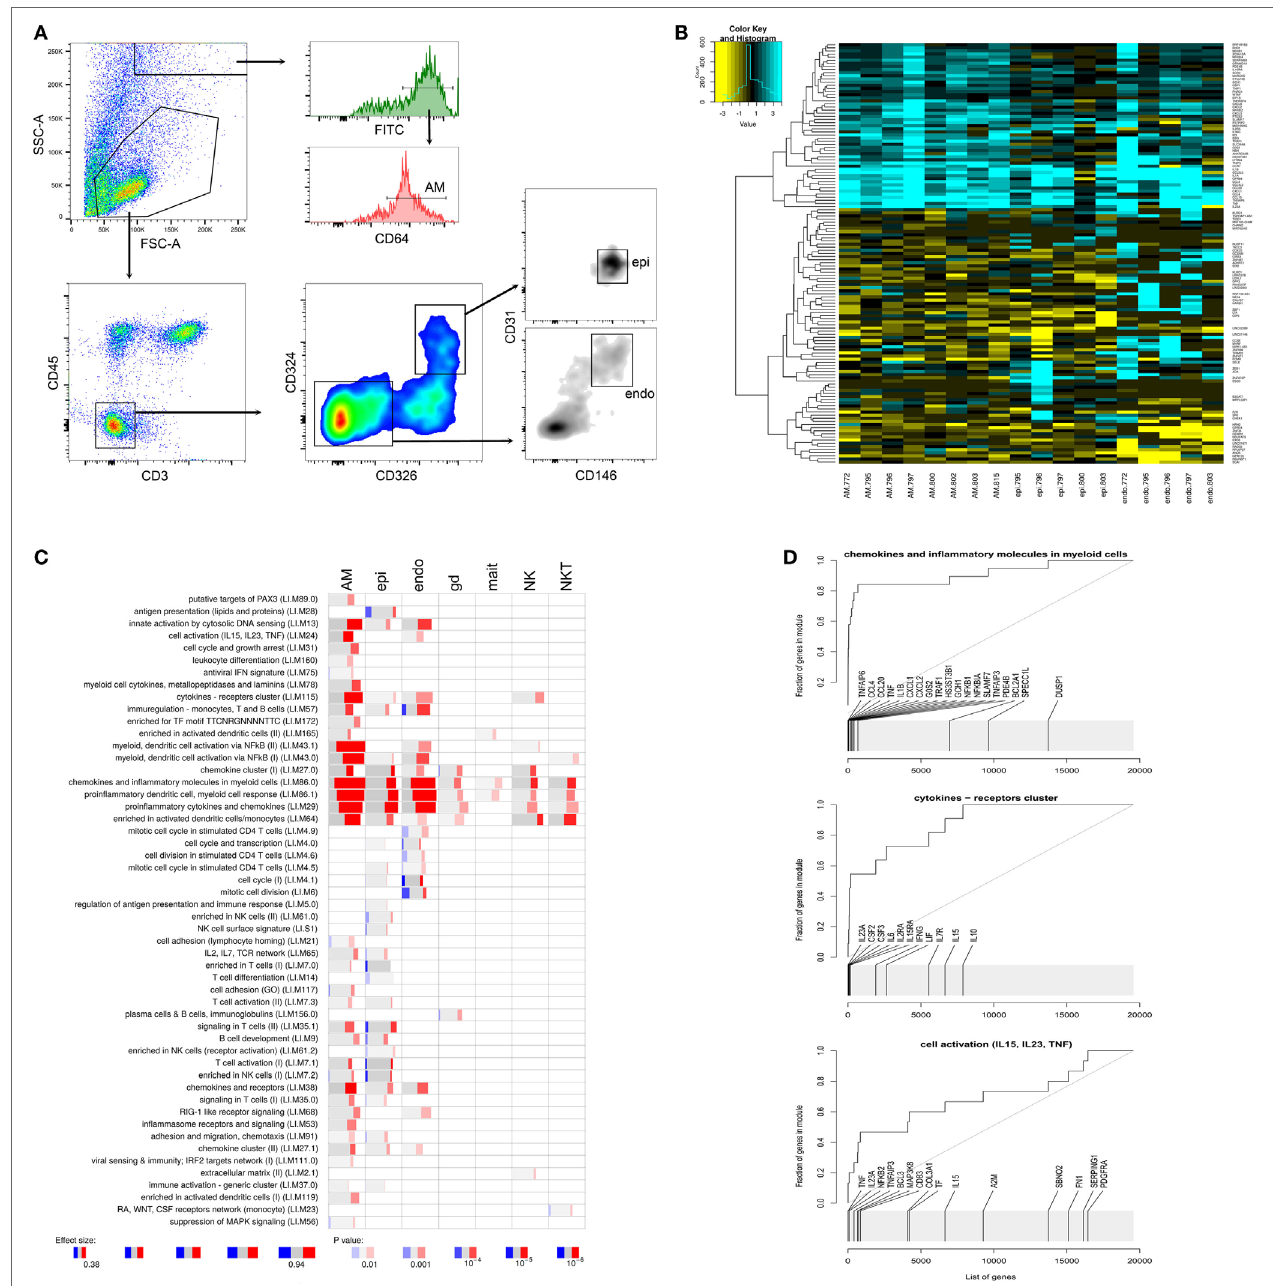
FigUre 3 | Analysis of distinct pulmonary cells. (a) Gating strategy for alveolar macrophages, epithelial cells (epi), and endothelial cells (endo). (B) Heatmap displaying log2 fold differences between cells from infected and uninfected for each donor. Shown are unique transcripts from a combined list of the top 50 differentially expressed transcripts for each cell type. (c) tmod gene module enrichments in innate pulmonary cells from infected versus uninfected tissue. gd, γ / δ T cells; mait, mucosal associated invariant T (MAIT) cells; natural killer (NK) and natural killer T (NKT) cells. (D) tmod evidence plots showing ranking of individual genes from three prominently enriched gene modules in panel (c) . A high resolution version of this figure is supplied as Figure S5 in Supplementary